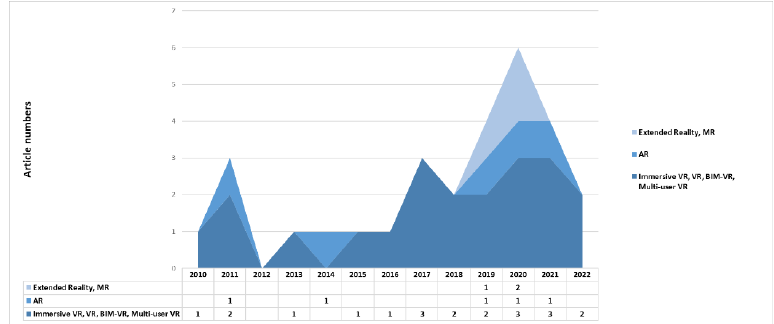
Figure 5. Types of ImVE technologies the review articles focused